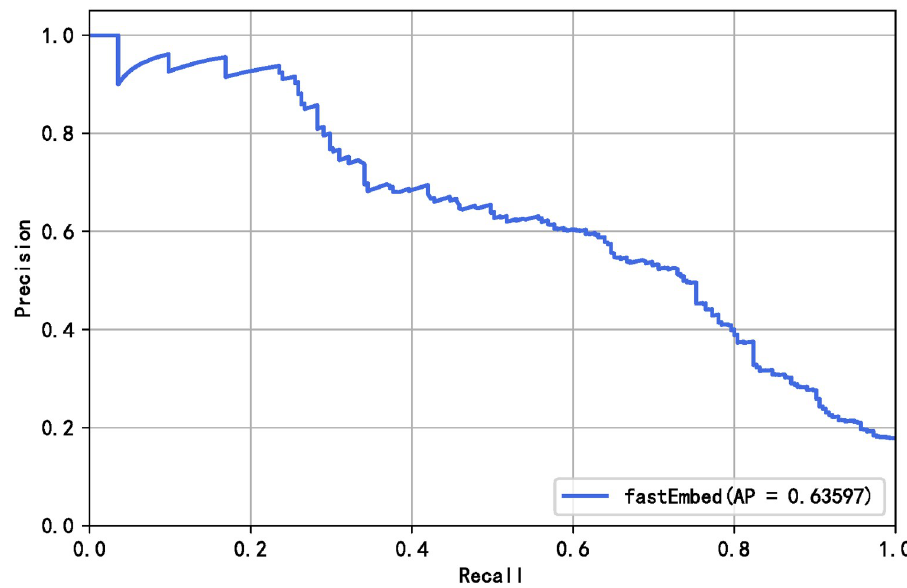
Fig 14. Precision-recall curve for Microsoft-Adobe vulnerabilities based on